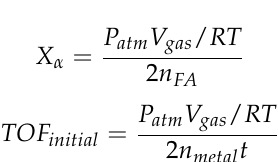
FA dehydrogenation, Table S1: ICP-OES (Pd) and XPS analyses (P, N, C, and Si) for Pd/NH 2 -P-GC before/after dehydrogenation reaction, Table S2: Initial TOF values for the decomposition of FA without additive over various heterogeneous